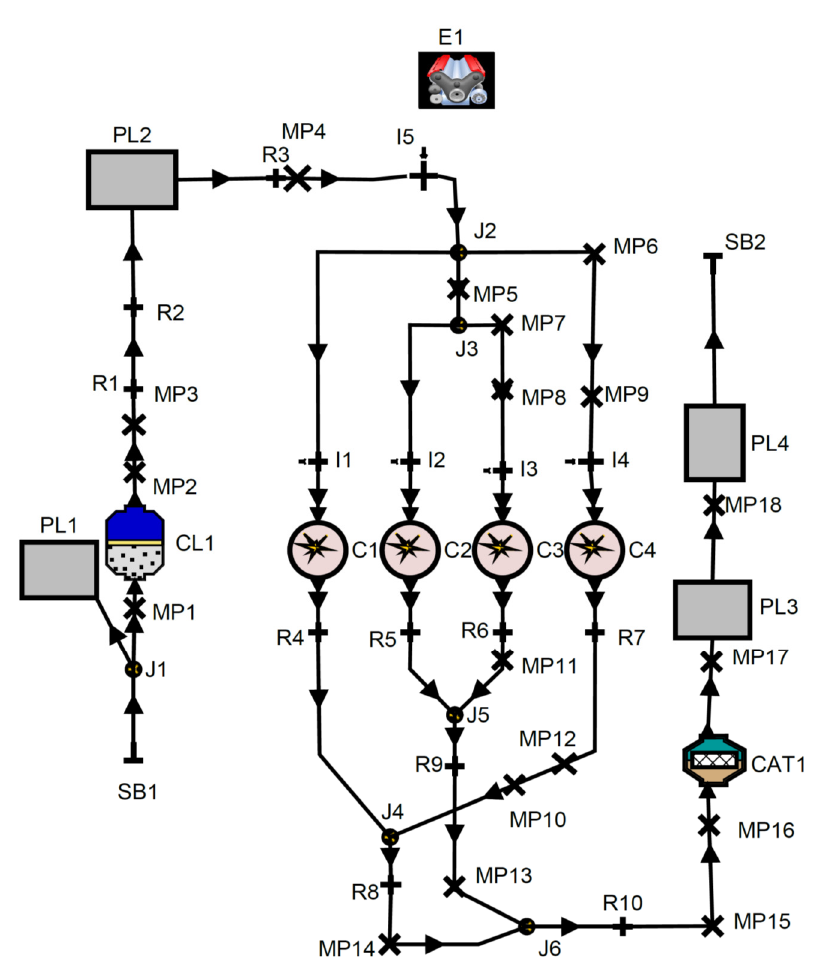
Figure 1. Engine block diagram in AVL BOOST .